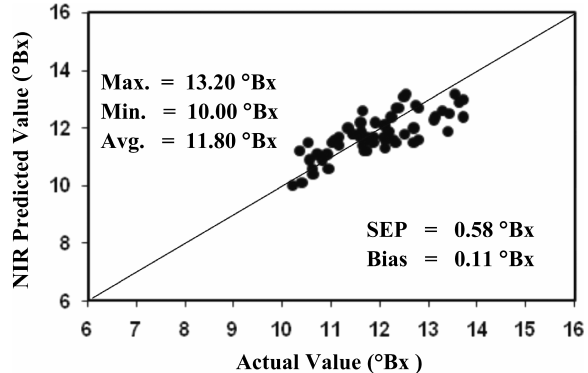
Fig. 5. Scatter plots of predicted and actual values of sugar content in the validation set.